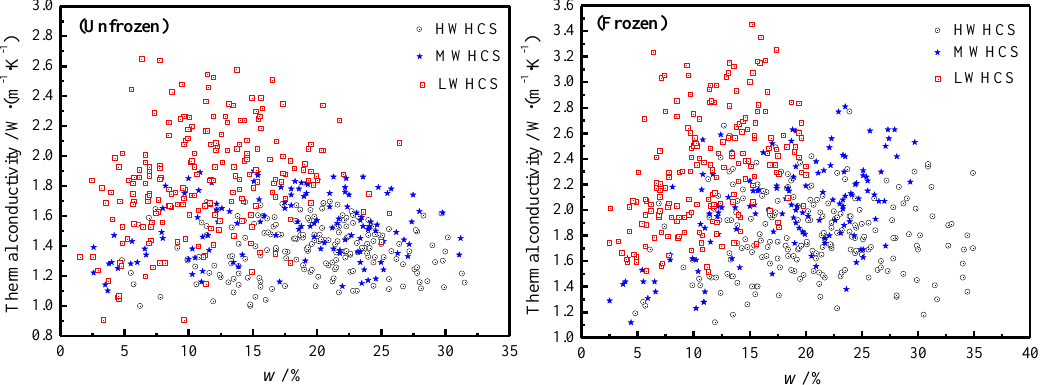
Figure 10. Thermal conductivities of three soil clusters with different water content.